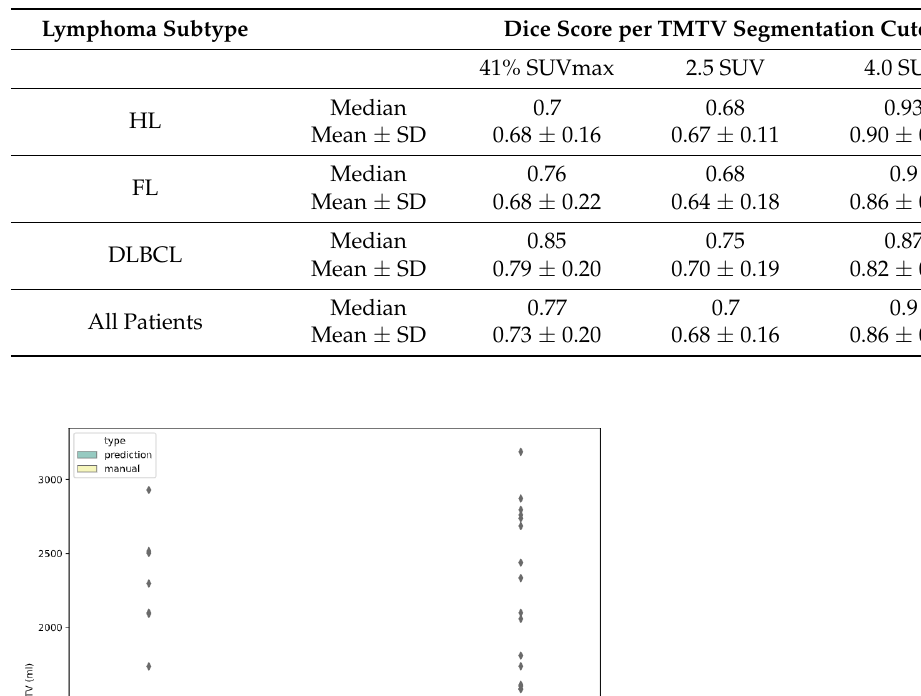
Table 2. Comparison between post-processed automated TMTV prediction and the corresponding manual TMTV values using dice coefficients for each methodology and lymphoma subtype.